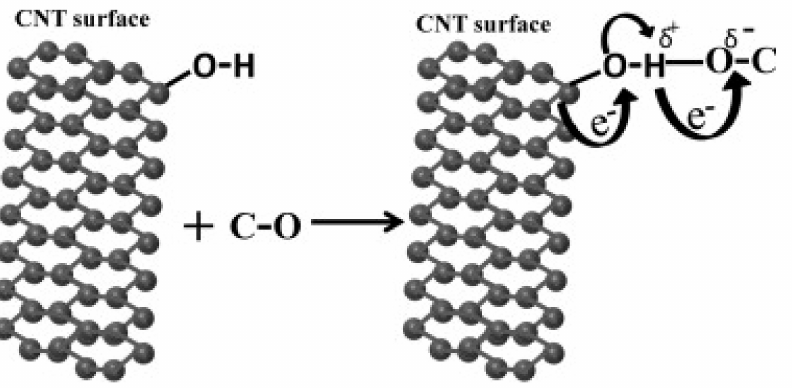
Figure 6. Adsorption of CO gas molecule on the hydroxyl modified CNTs. Reproduced from